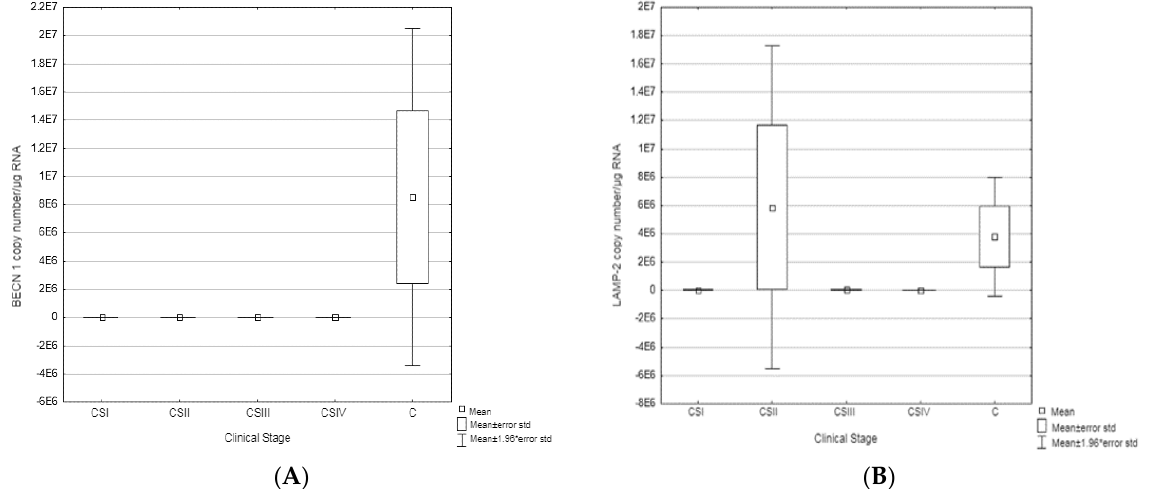
Figure 1. ( A ). Comparison of the number of BECN1 mRNA molecules in clinical stages (I-IV) of CRC vs controls (C). ( B ). Comparison of the number of LAMP-2 mRNA molecules in clinical stages (I-IV) of CRC vs controls (C).